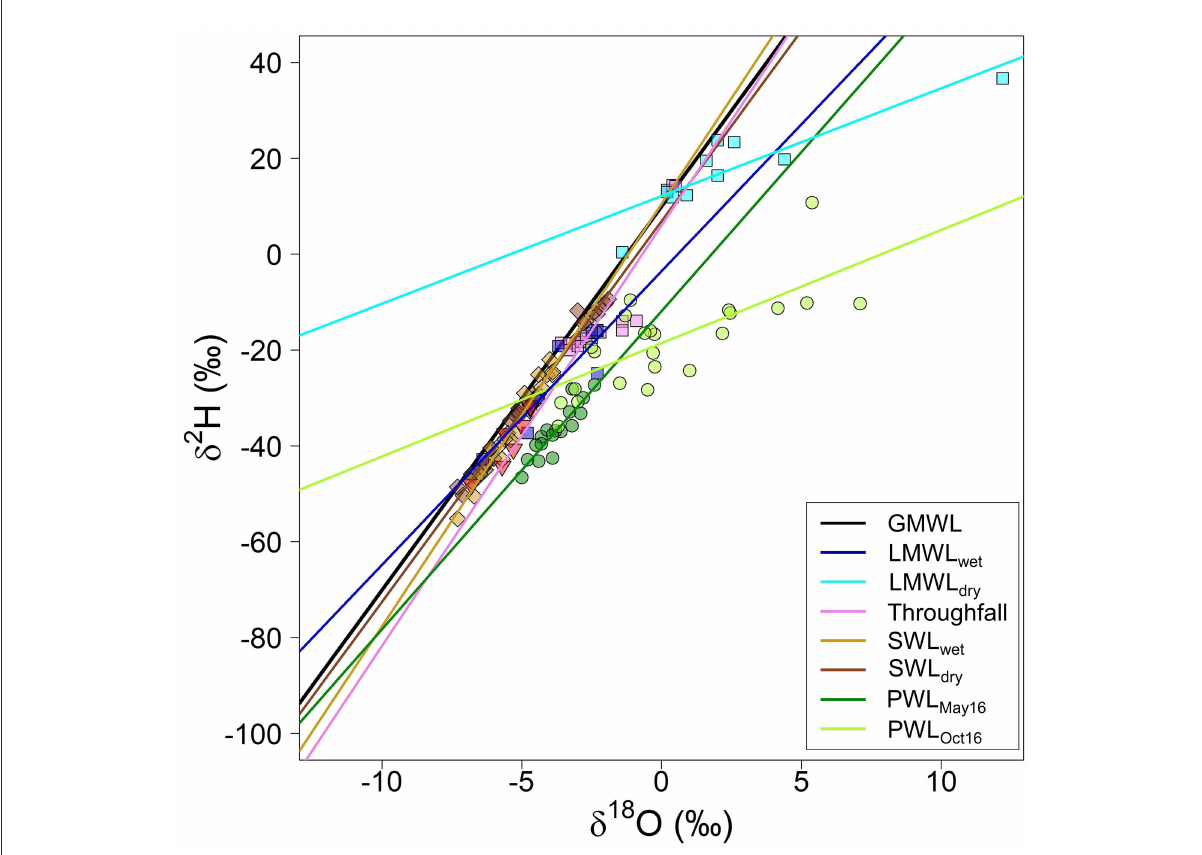
FIGURE4 Dual isotope plot of the global meteorological water line (GMWL), local meterological water line for the wet (LMWLwet) and the dry periods (LMWLdry, taken in May, June and October 2016), and throughfall; soil water line that comprise the isotopic soil signal at different soil depths in May 2016 (SWLMay16) and in October 2016 (SWLOct16); plant water line that comprises the isotopic signal of the xylem in May 2016 (PWLMay16) and in October 2016 (PWLOct16). May 2016 corresponds to the wet-to-dry (WTD) transition period, and October 2016 corresponds to the dry-to-wet (DTW) transition